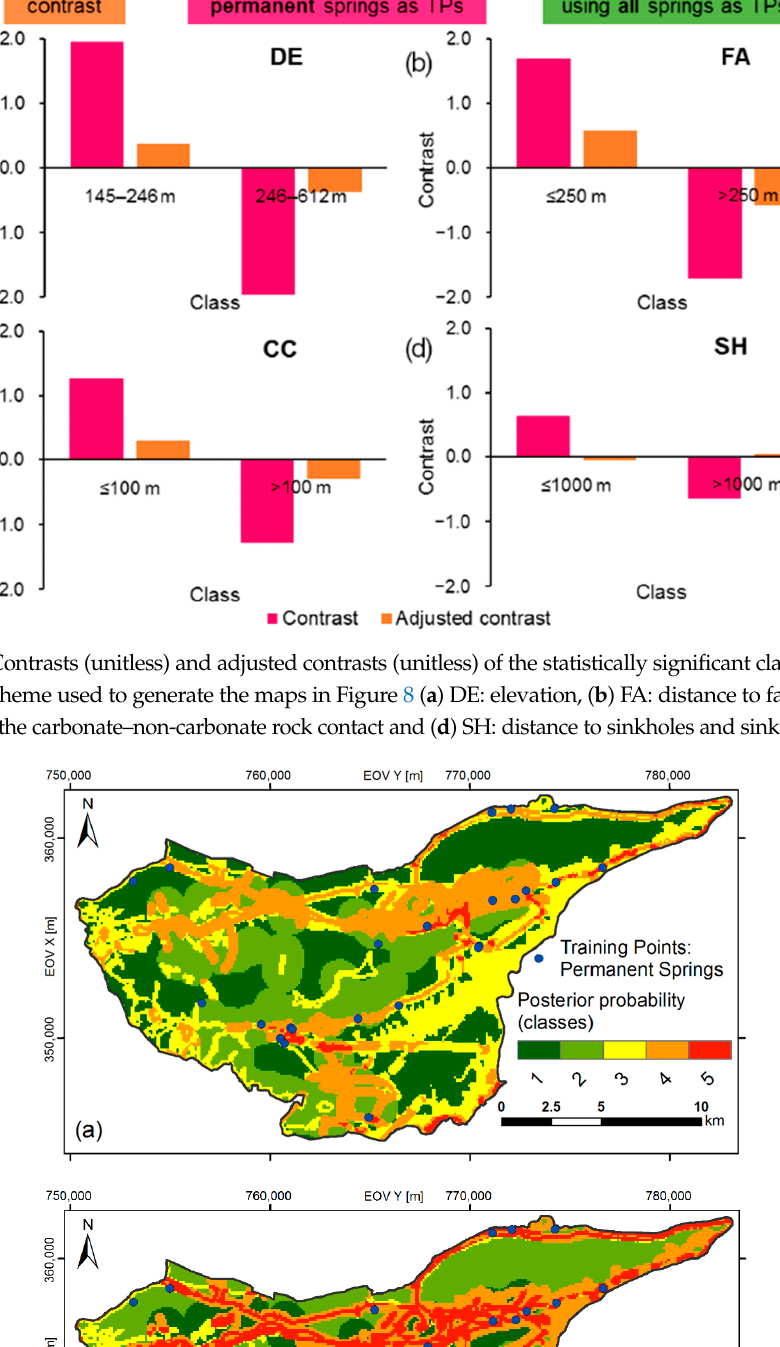
Figure 8. ( a ) Non-adjusted predictive probability map, ( b ) adjusted predictive probability map.